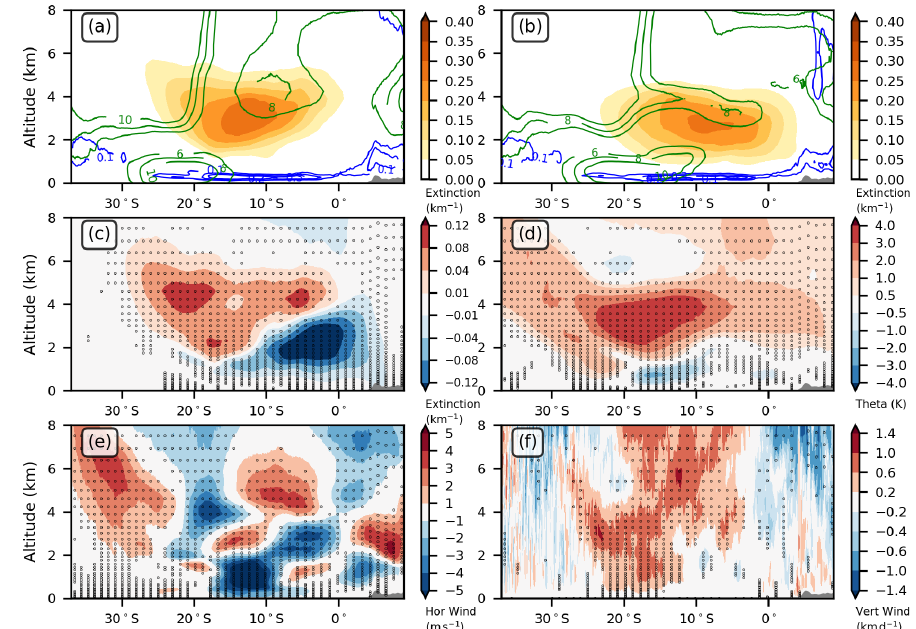
Figure A2. Same as Fig. A1 but for fields averaged between 5 and 10 ◦